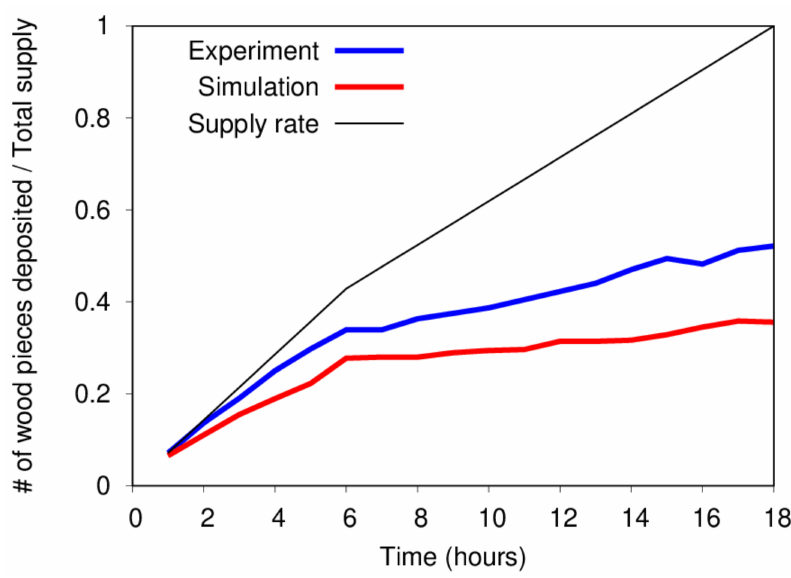
Figure 4. Comparison between experiment and simulation of rate of deposition of supplied wood pieces onto modeled braided